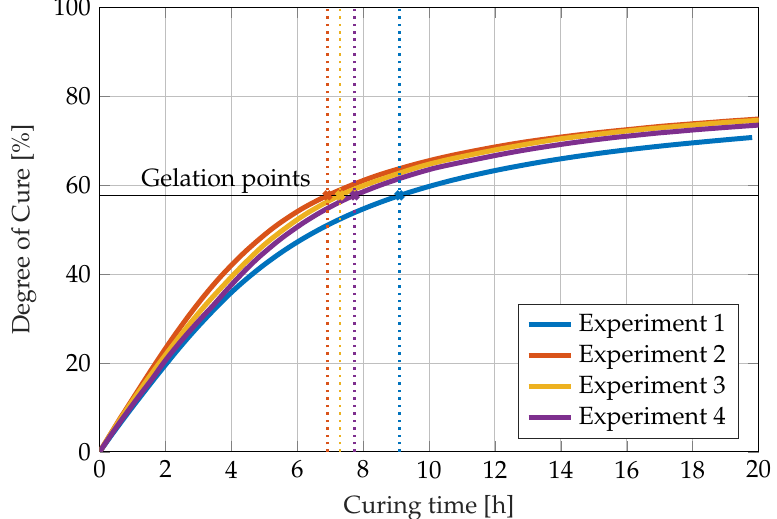
Figure 6. Degree of cure calculated from measured temperature data during the curing reaction of RIMR 426 resin with RIMH 435 curing agent using a kinetic model.